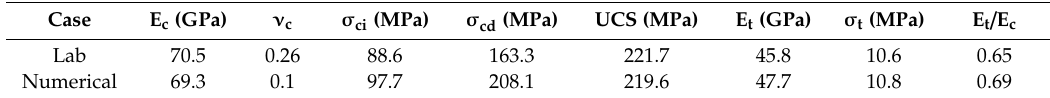
Table 2. Comparison of macroresponses observed in the laboratory Lac du Bonnet granite and numerical